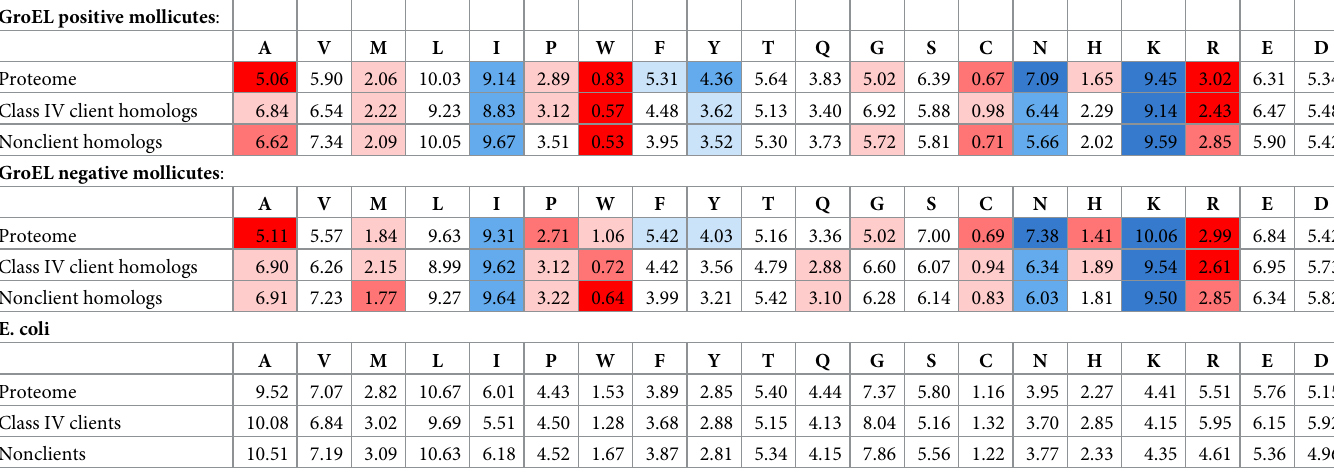
The overall compositions of E . coli and the GroE + and GroE - mollicutes are also provided. The blue cells mark amino acid for which the frequency in mollicute is higher (color gradient starting with 10% difference) compared to the corresponding amino acid frequency in E . coli , while the red cells mark amino acid with frequency that is lower (color gradient starting with 10% difference) compared with the corresponding frequency in E . coli